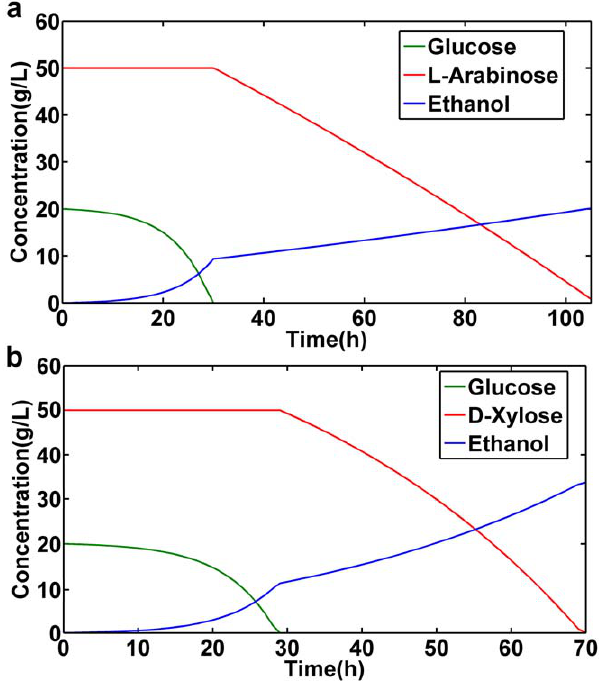
Figure 3. Dynamic flux balance analysis. The glucose, D-xylose and ethanol are shown as a function of time for anaerobic S. cerevisiae batch growth on glucose and D-xylose. (a) Without cofactor balance with engineered D-xylose pathway. (b) With cofactor balanced D-xylose pathway.